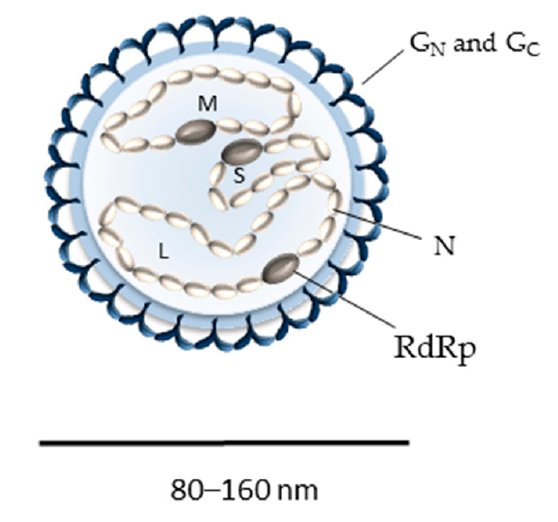
Figure 1. Schematic representation of a bunyavirus particle. The three viral genomic segments are termed according to their size: S (small), M (medium) and L (large). Abbreviations: G N : glycoprotein G N ; G C : glycoprotein G C ; N: nucleoprotein; RdRp: RNA-dependent RNA